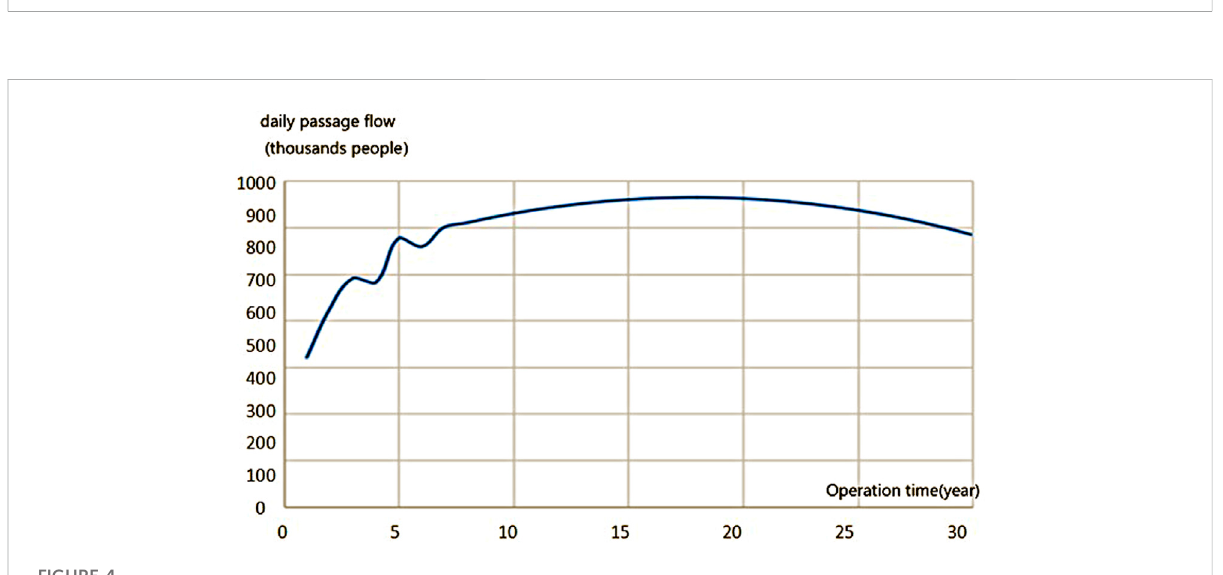
FIGURE 4 Passenger fl ow of Beijing Metro Line 4